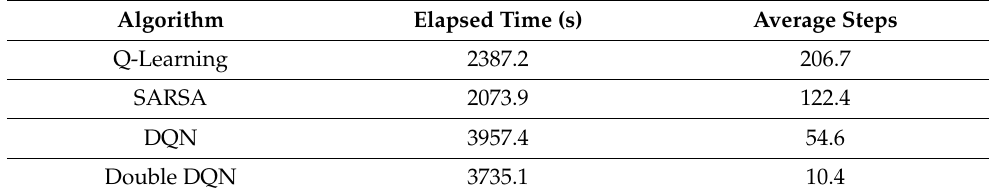
Table 3. Average Steps and Elapsed Time of Different Reinforcement Learning